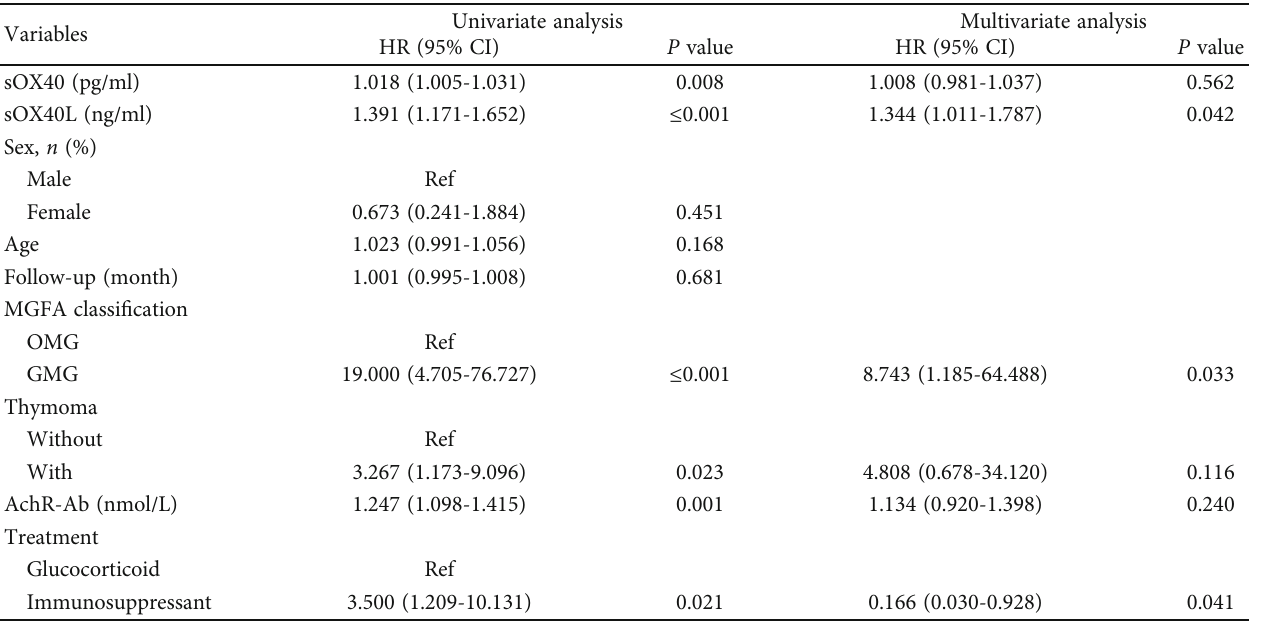
Table 8: Univariate and multivariate logistic regression risk models of the risk of relapse of MG (soluble molecules).